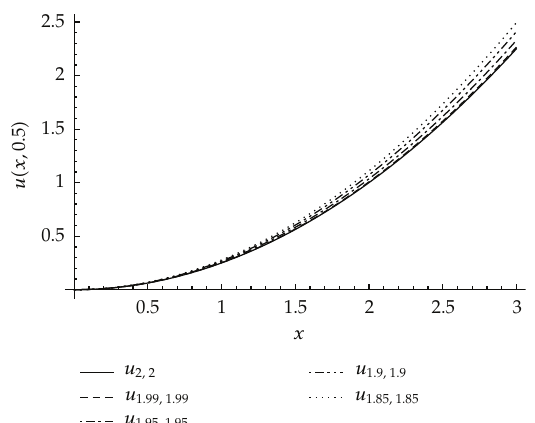
Figure 3: u (cid:2) x, 0 . 5 (cid:3) of Example 4.1 Case 3 for 6th-order HPM approximation as parameterized by α and β